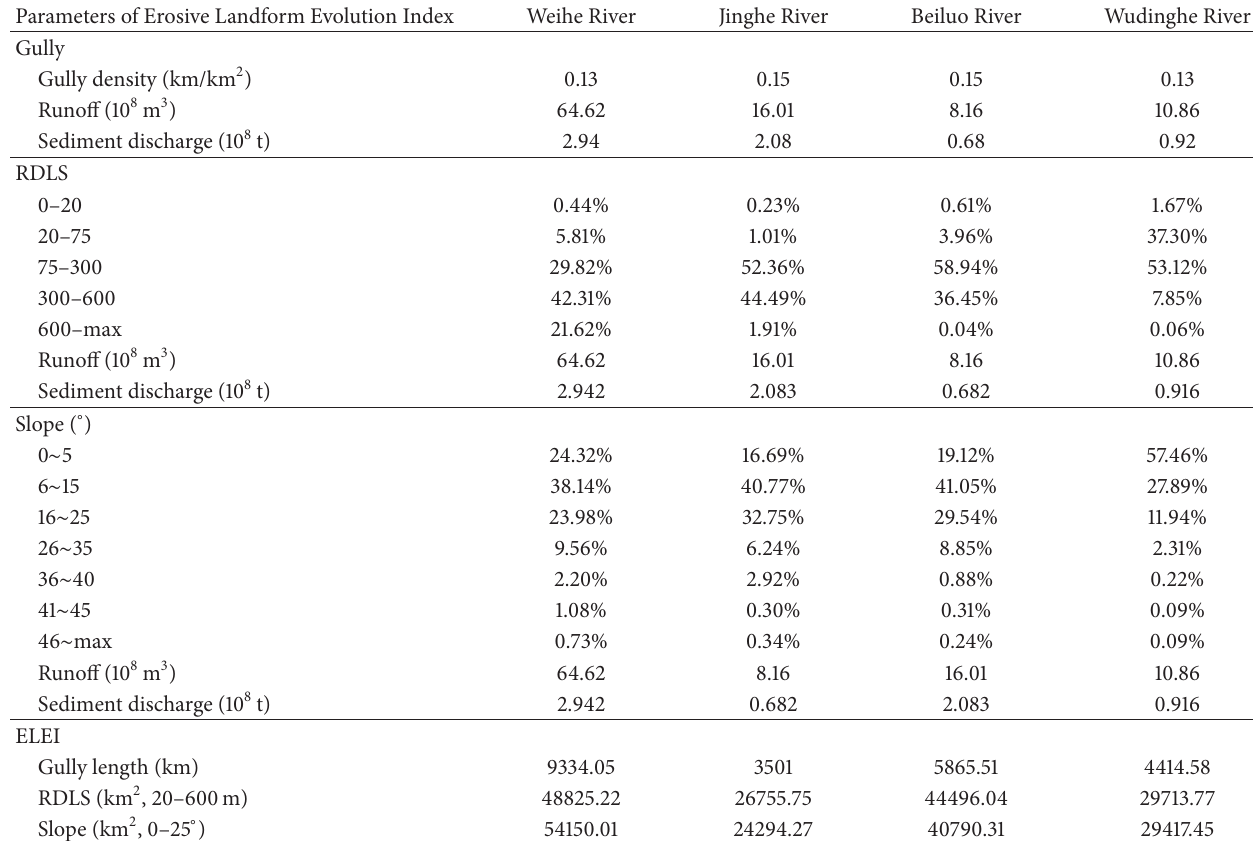
Table 1: Parameters configuration of Erosive Landform Evolution Index